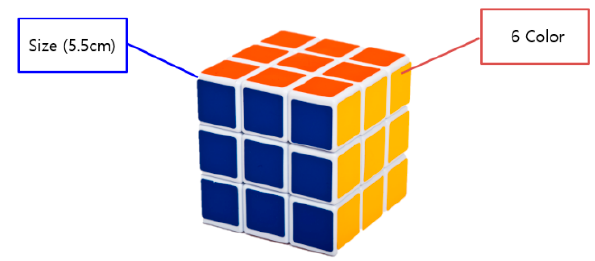
Figure 3. Real cubic puzzle (or cube) provided as a basis for the scale comparison. It was 5.5 cm in size and had different colors on each side.